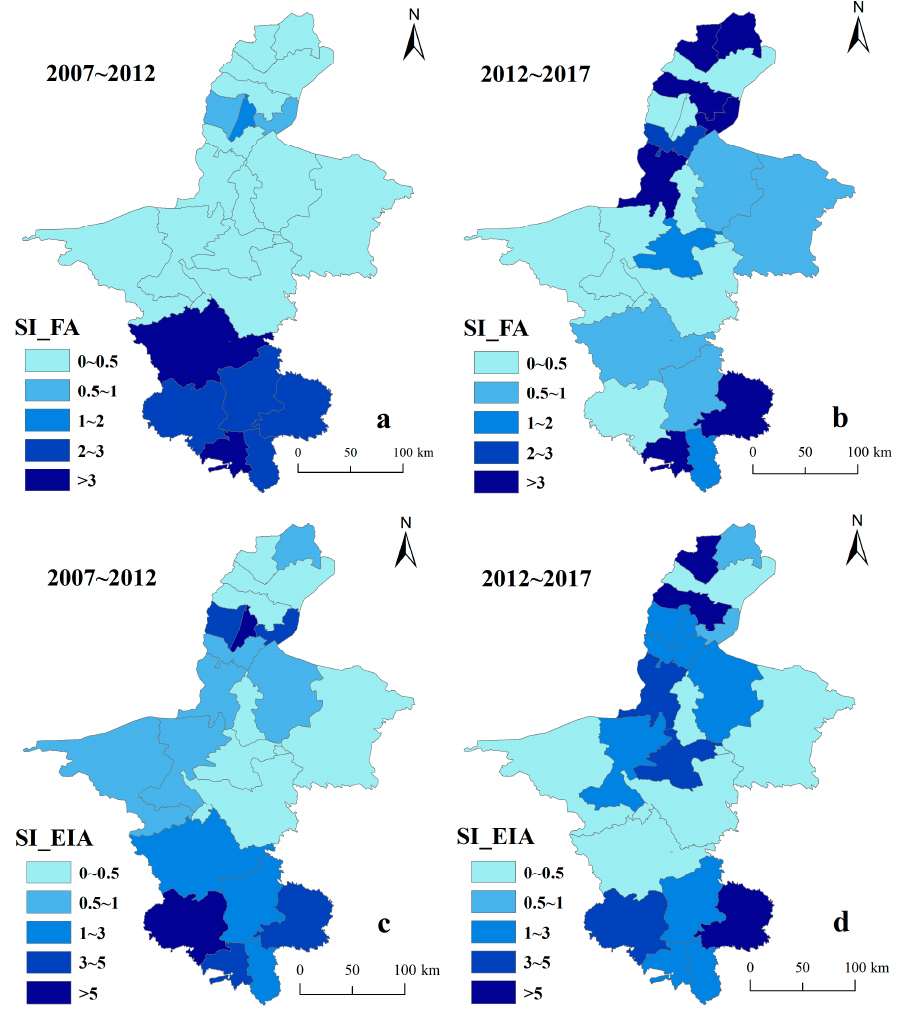
Figure 7. Sensitivity of irrigation water use during 2007–2012 and 2012–2017. ( a , b ) represent sensitivity index of AIW to FA, respectively; ( c , d ) represent sensitivity index of AIW to EIA,